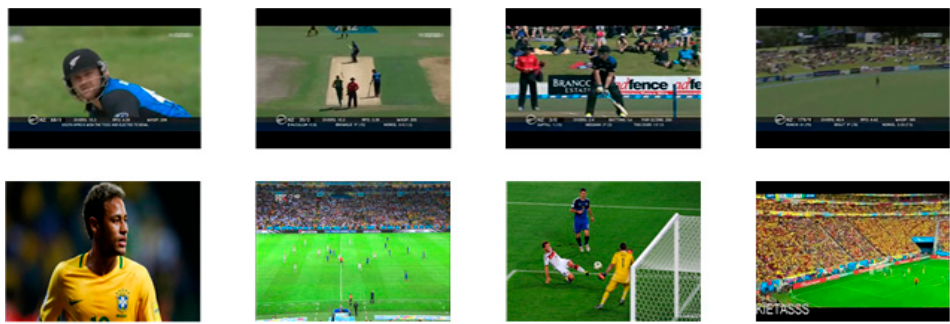
Figure 5. Snapshots for cricket (row-1) and soccer (row-2) videos.